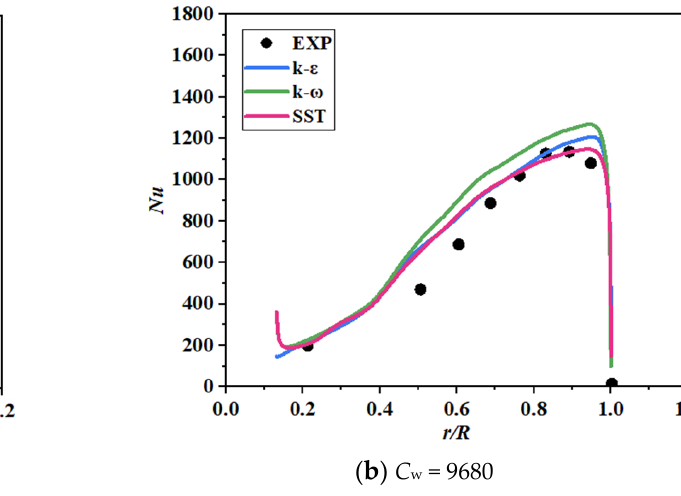
Figure 10. Nusselt number distribution.